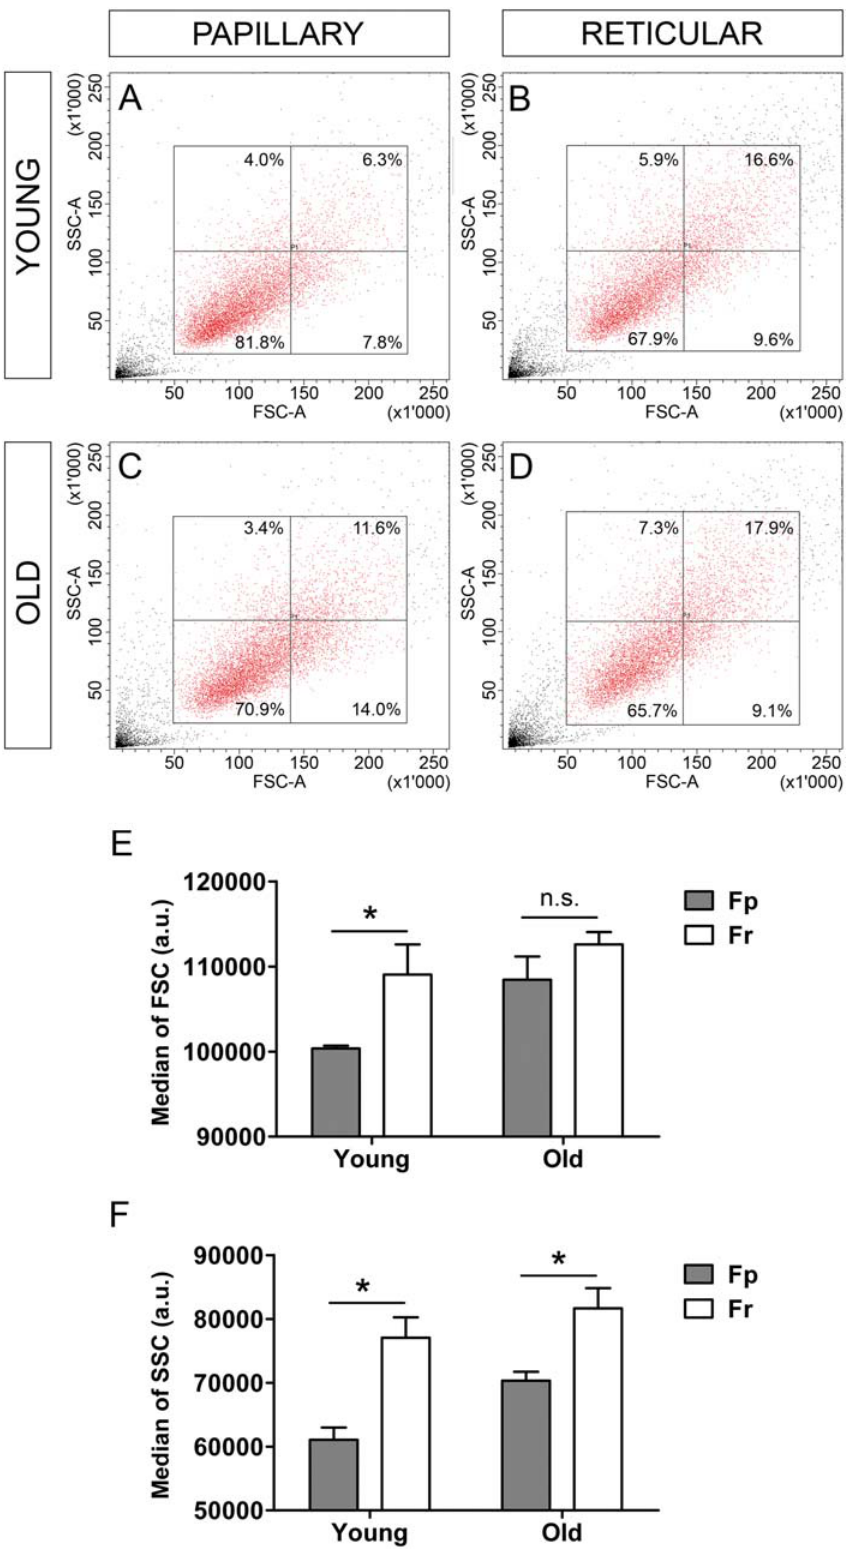
Figure 4. Evolution with age of Fp and Fr morphology. Fp and Fr samples from 3 young donors (19 yr, 21 yr, and 26 yr) and 3 old donors (57 yr, 62 yr, and 74 yr) were examined by flow cytometry according to the morphological parameters of size (forward scatter, FSC) and granularity (side scatter, SSC). FSC versus SSC dot plots corresponding to a typical pair of young [19 yr] Fp (A) and Fr (B), and a typical pair of old [74 yr] Fp (C) and Fr (D). Median FSC and SSC values were determined for the different samples. (E) Comparison of Fp and Fr FSC values in young and old donors (mean 6 SEM, n=3). (F) Comparison of Fp and Fr SSC values in young and old donors (mean 6 SEM) (*p , 0.05; n.s.=not significant). a.u.=arbitrary unit.